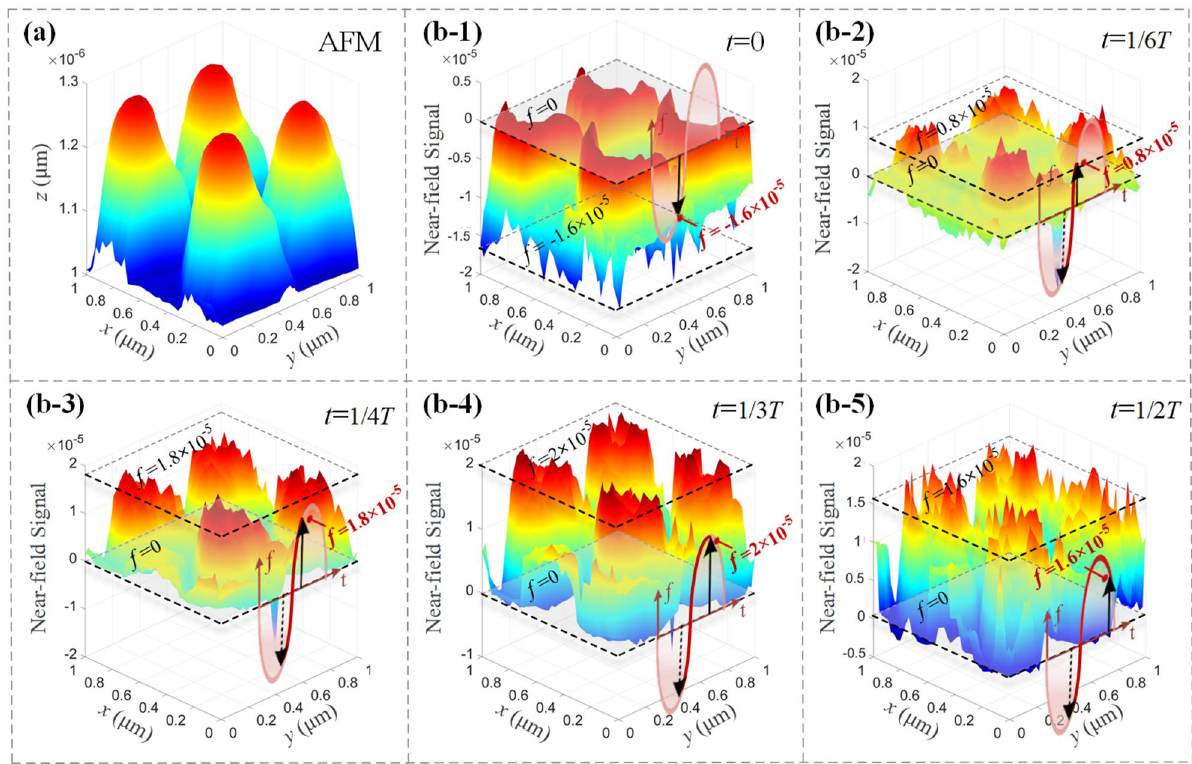
Figure 6. Time evolution of the near-field lightwaves excited over the outside surface of the GGNCT-III. ( a ) Surface morphology of a partial GGNCT-III. measured using AFM. ( b ) Several typical near-field lightwaves excited at different measurement moment including t = 0 to ( b-1 ), t = 1/6 T to ( b-2 ), t = 1/4 T to ( b-3 ), t = 1/3 T to ( b-4 ), and t = 1/2 T to ( b-5